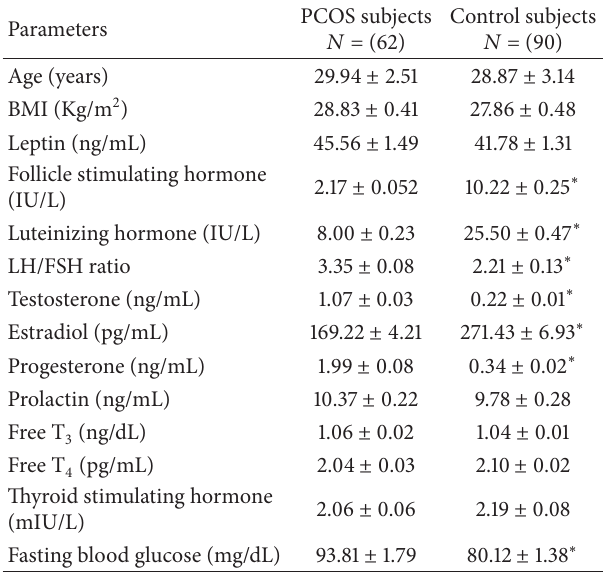
Table 1: Comparison of study parameters in PCOS and control